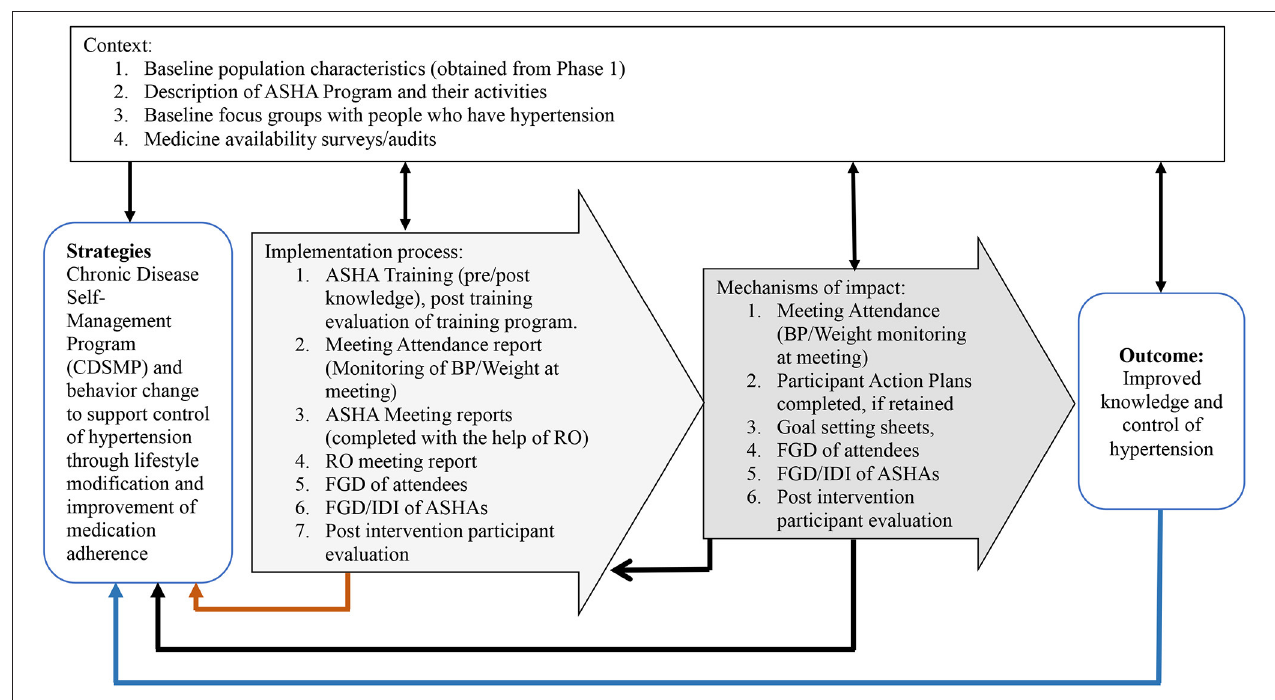
FIGURE 1 | Description of intervention activities/data tools to inform process evaluation using the United Kingdom Medical Research Council framework (17). ASHA, Accredited Social Health Activist; BP, Blood Pressure; RO, Research Officer; FGD, Focus Group Discussion; IDI, In Depth